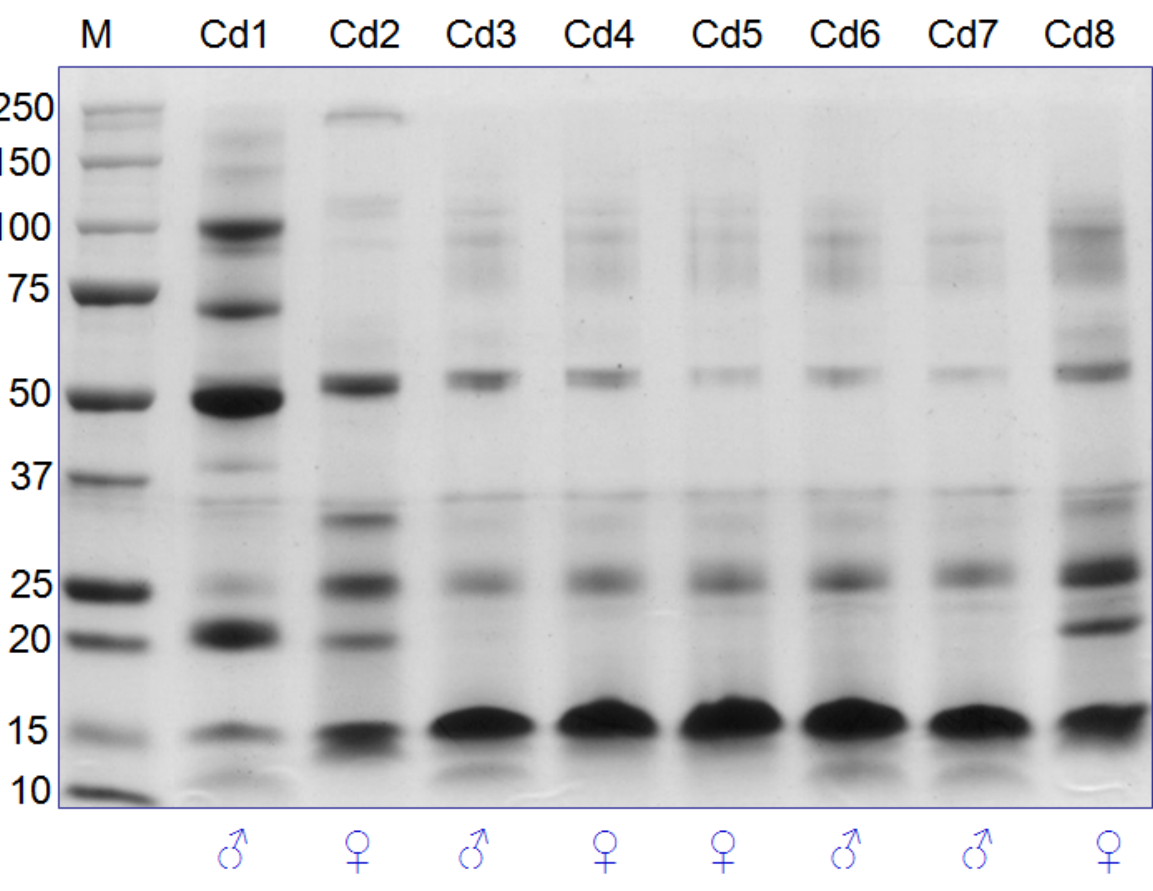
Figure 1. Electrophoretic analysis of C. durissus cumanensis venoms. Venoms from the Guajira male (Cd1), the Tolima female (Cd2), and male (Cd3, Cd6, Cd7) and female (Cd4, Cd5, Cd8) offspring were subjected to SDS-PAGE under non-reducing